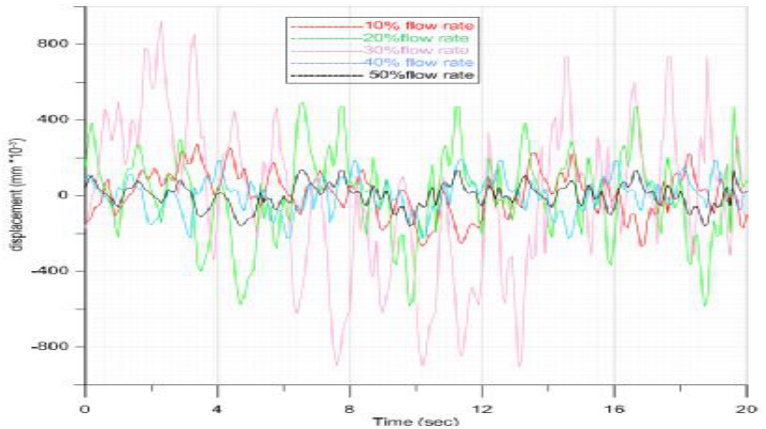
Fig. 11. Displacement measurement of globe valve at different flow rate cross the